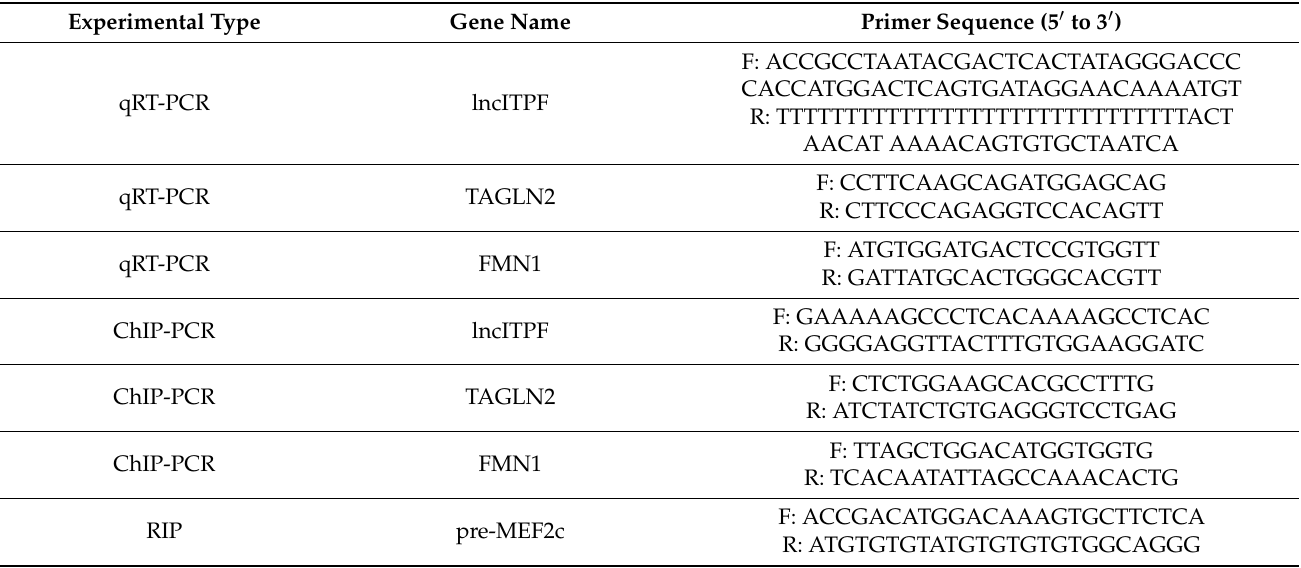
Table 2. The primers used in